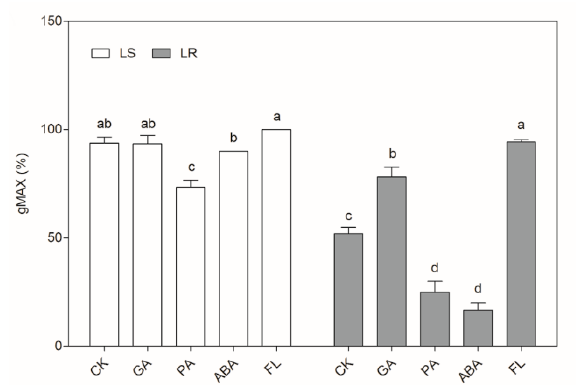
Figure 5. The maximum germination (gMAX) of LS and LR with exogenous hormones application. CK: water, GA: gibberellin, PA: paclobutrazol, ABA: abscisic acid, FL: fluridone. Bars are mean ± standard error (n = 5). Values in a column followed by the different letters means significant difference ( p ≤ 0.05).